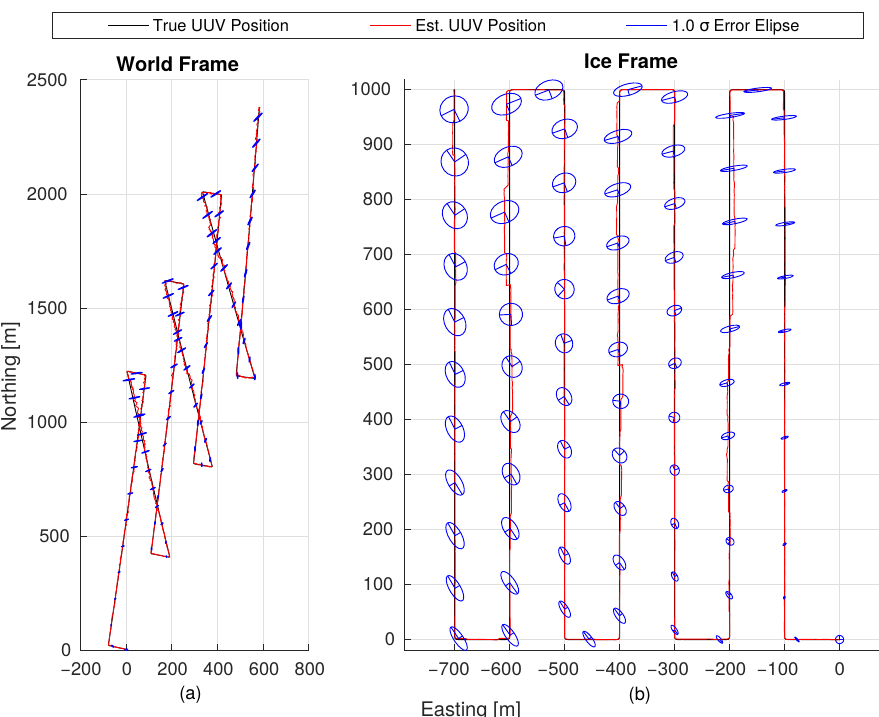
Figure 2. True (black) and estimated (red) vehicle tracklines are shown for exp1, with 500 m GNSS spacing, in the world ( a ) and ice ( b ) frames, with 1 σ vehicle x − y covariance ellipsoids shown in blue. The simulated uninhabited underwater vehicles (UUV) navigated an ice-relative serpentine pattern, while the simulated ice floe traveled at a constant velocity of 0.25 m/s (approximately 0.5 knots) northeast, with constant angular velocity of 2 ◦ /h anticlockwise (viewed from above). While not shown, the ship remained fixed to the ice floe, and thus tracked Northeast. The highly eccentric error ellipsoids in the world frame are due to the poor ranging geometry that exists at large vehicle-ship standoff